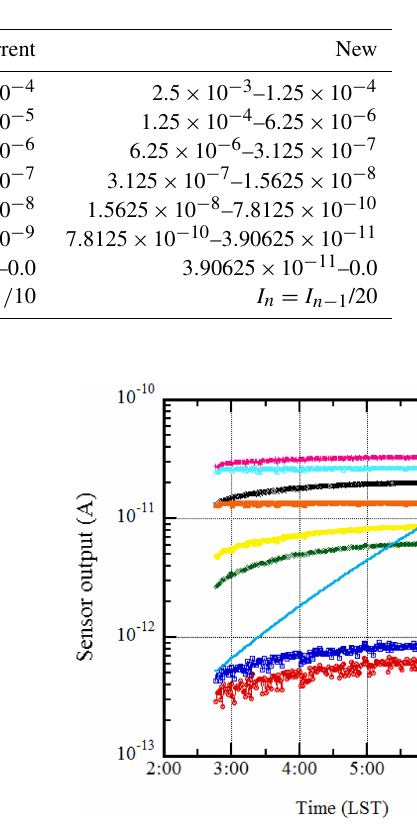
Figure 2. An example of the measurements taken on 14 Octo- ber 2017 at NOAA/MLO. The phase angle of the moon (right y axis) is from 117.6 to 118.0 ◦